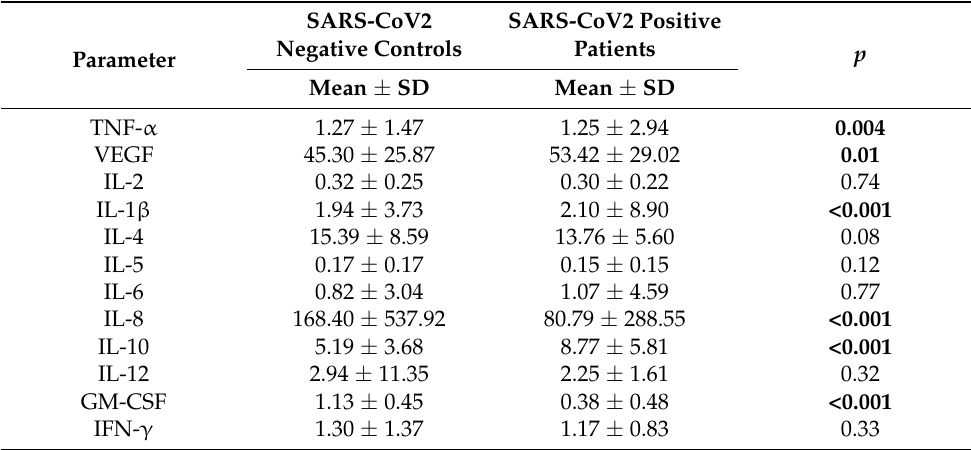
Figure 1. Boxplots showing tear film cytokine levels in SARS-CoV-2-positive patients and SARS-CoV- 2-negative controls. p values are written above the boxplots. Table 3. Tear film cytokine levels among patients with positive and negative SARS-CoV-2 PCR results (pg/mL). Statistically significant values are shown in